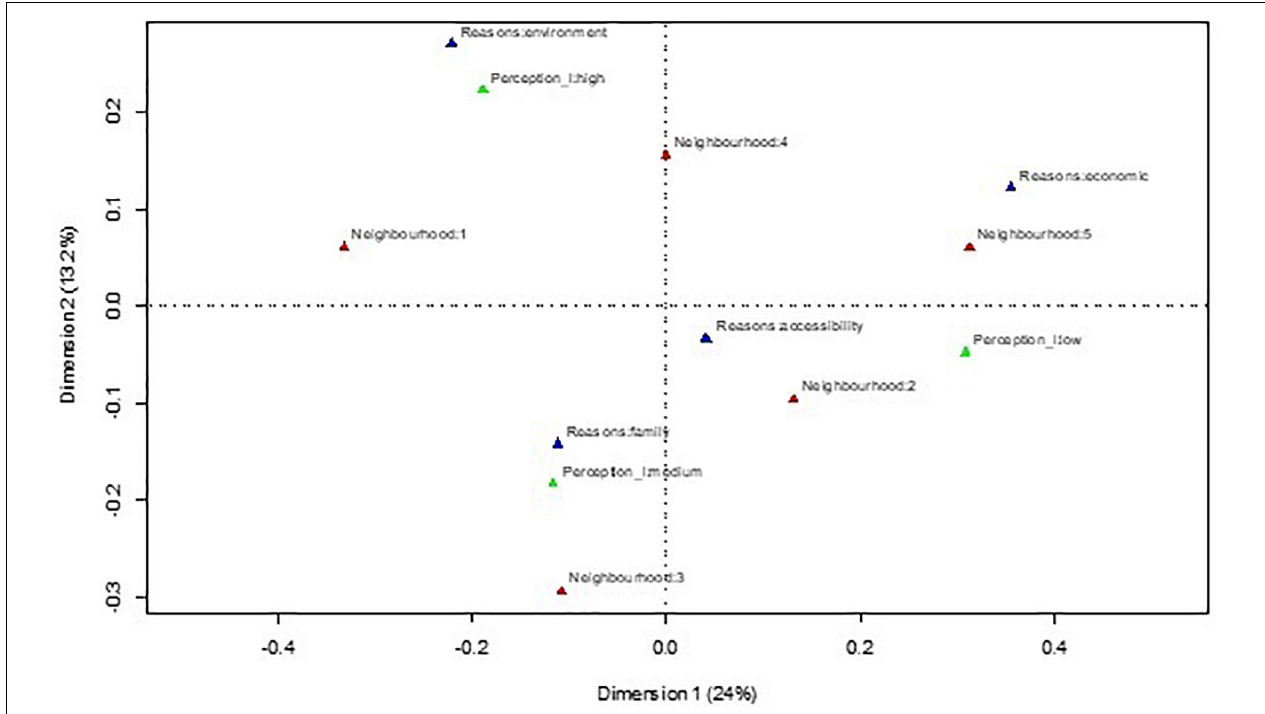
FIGURE 1 | Correspondence analysis between neighborhood, levels of perception and reasons to live in the neighborhood.